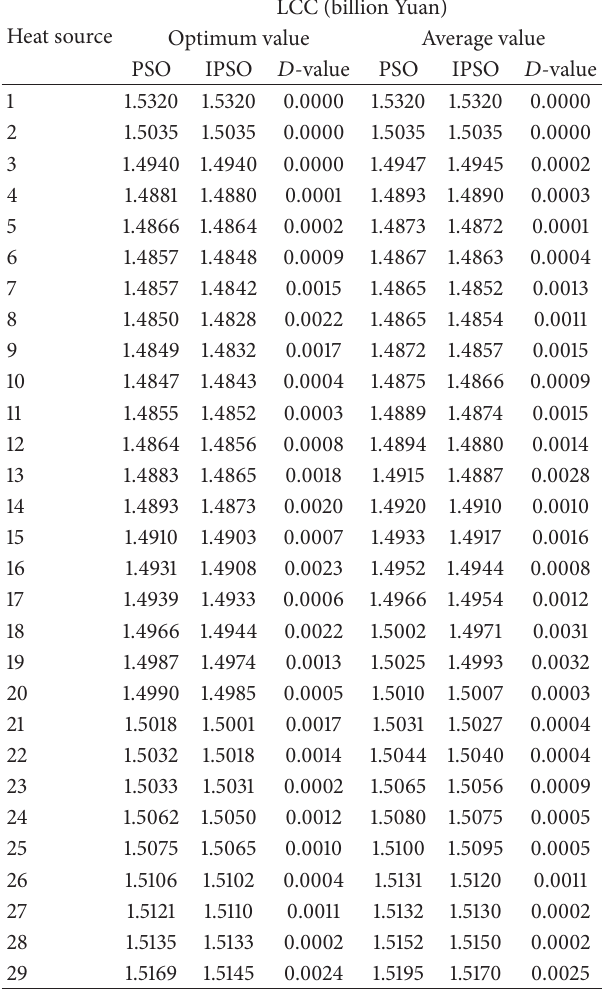
Table 2: Algorithm calculation results